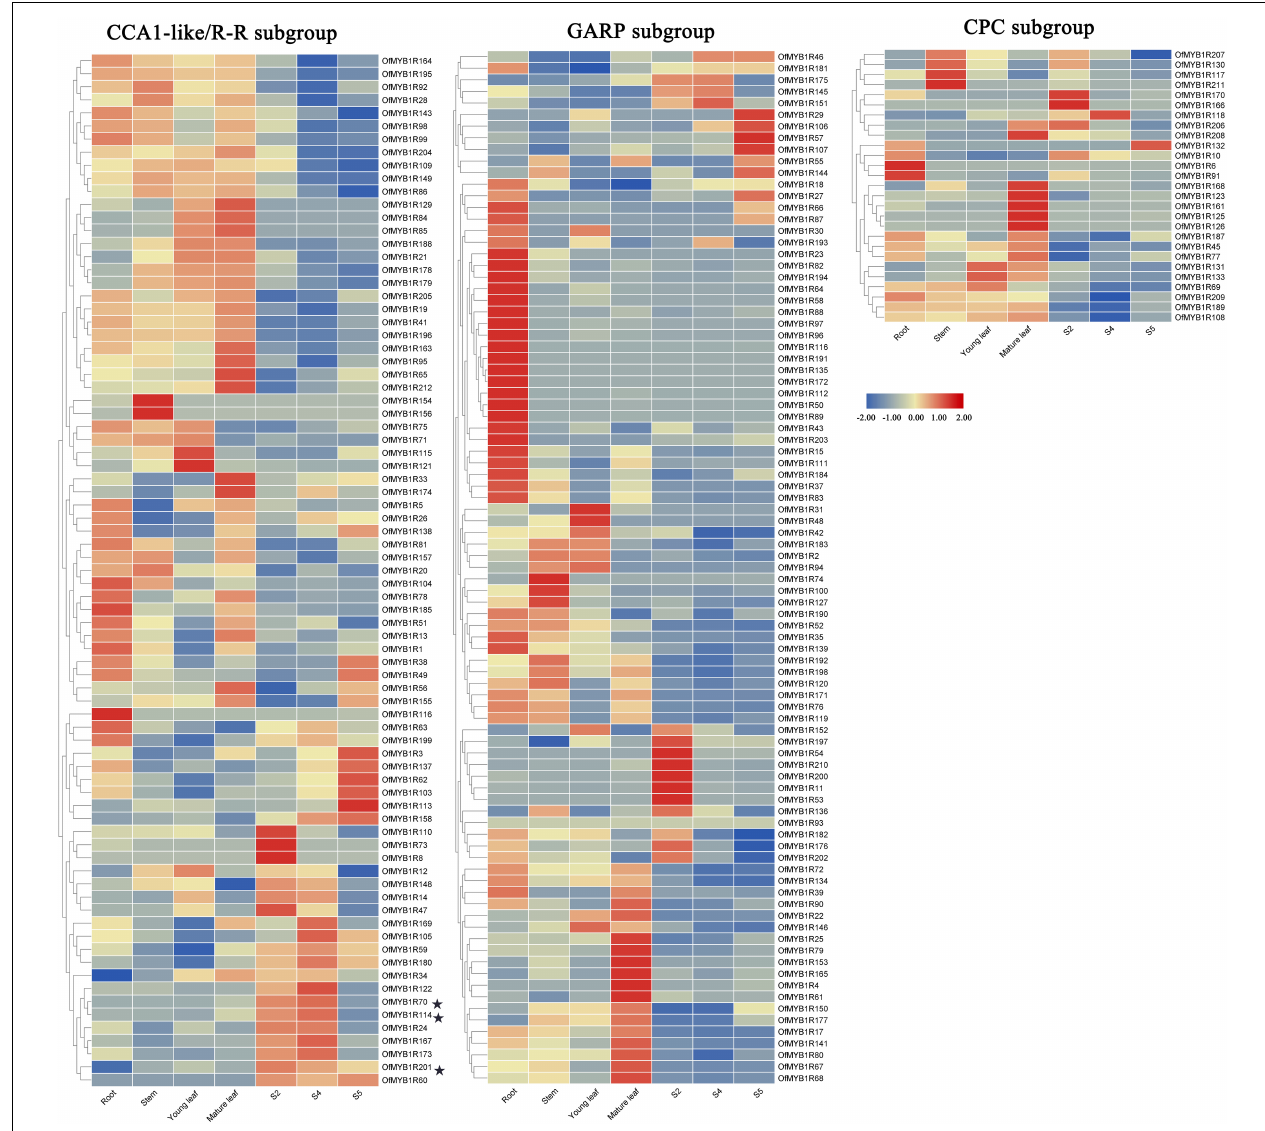
FIGURE 4 | Expression analysis of 194 OfMYB-related genes in seven organs. The RPKM values were log 2 transformed. S2 represents the bud-eye stage, S4 the represents full blooming stage, and S5 represents the flower fading stage. Genes with no transcriptome data are not shown. The candidate genes in the biosynthesis of floral aroma are marked by